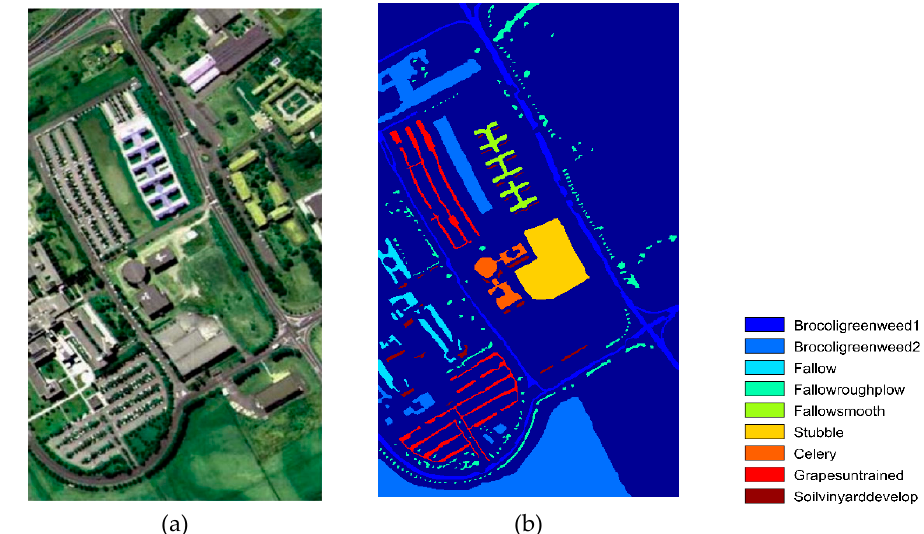
Figure 4. Pavia University dataset. ( a ) False color image. ( b ) Ground-truth.